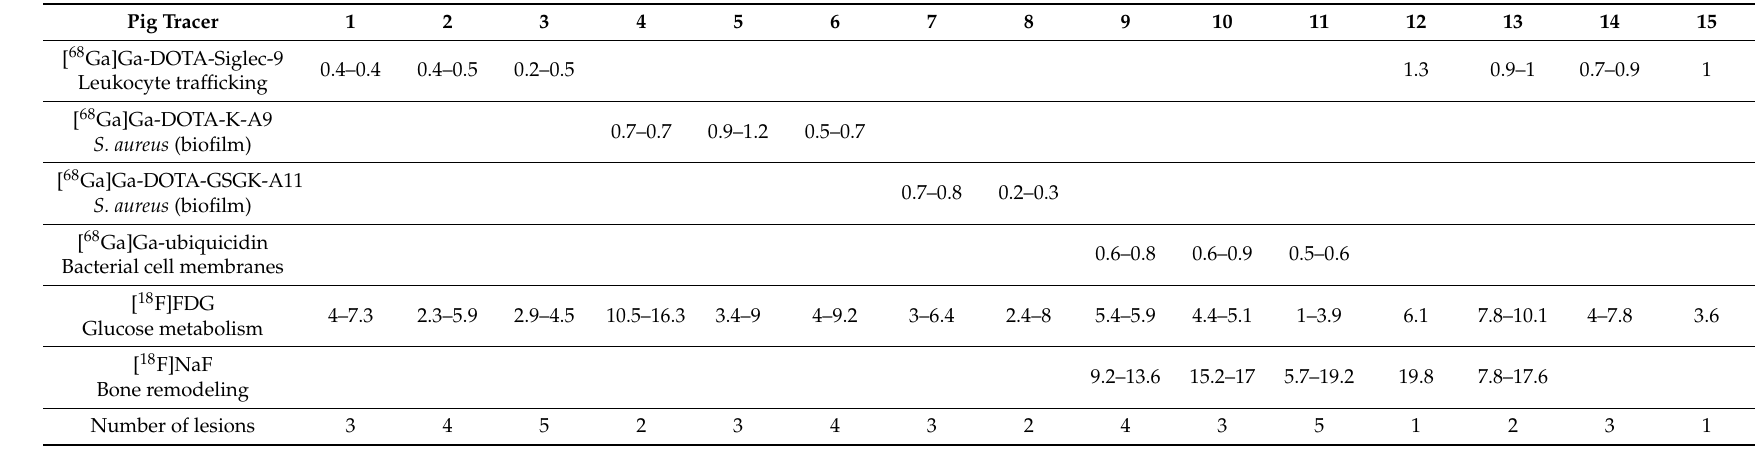
Table 1. Standard uptake values (SUV) of di ff erent radiotracers in OM